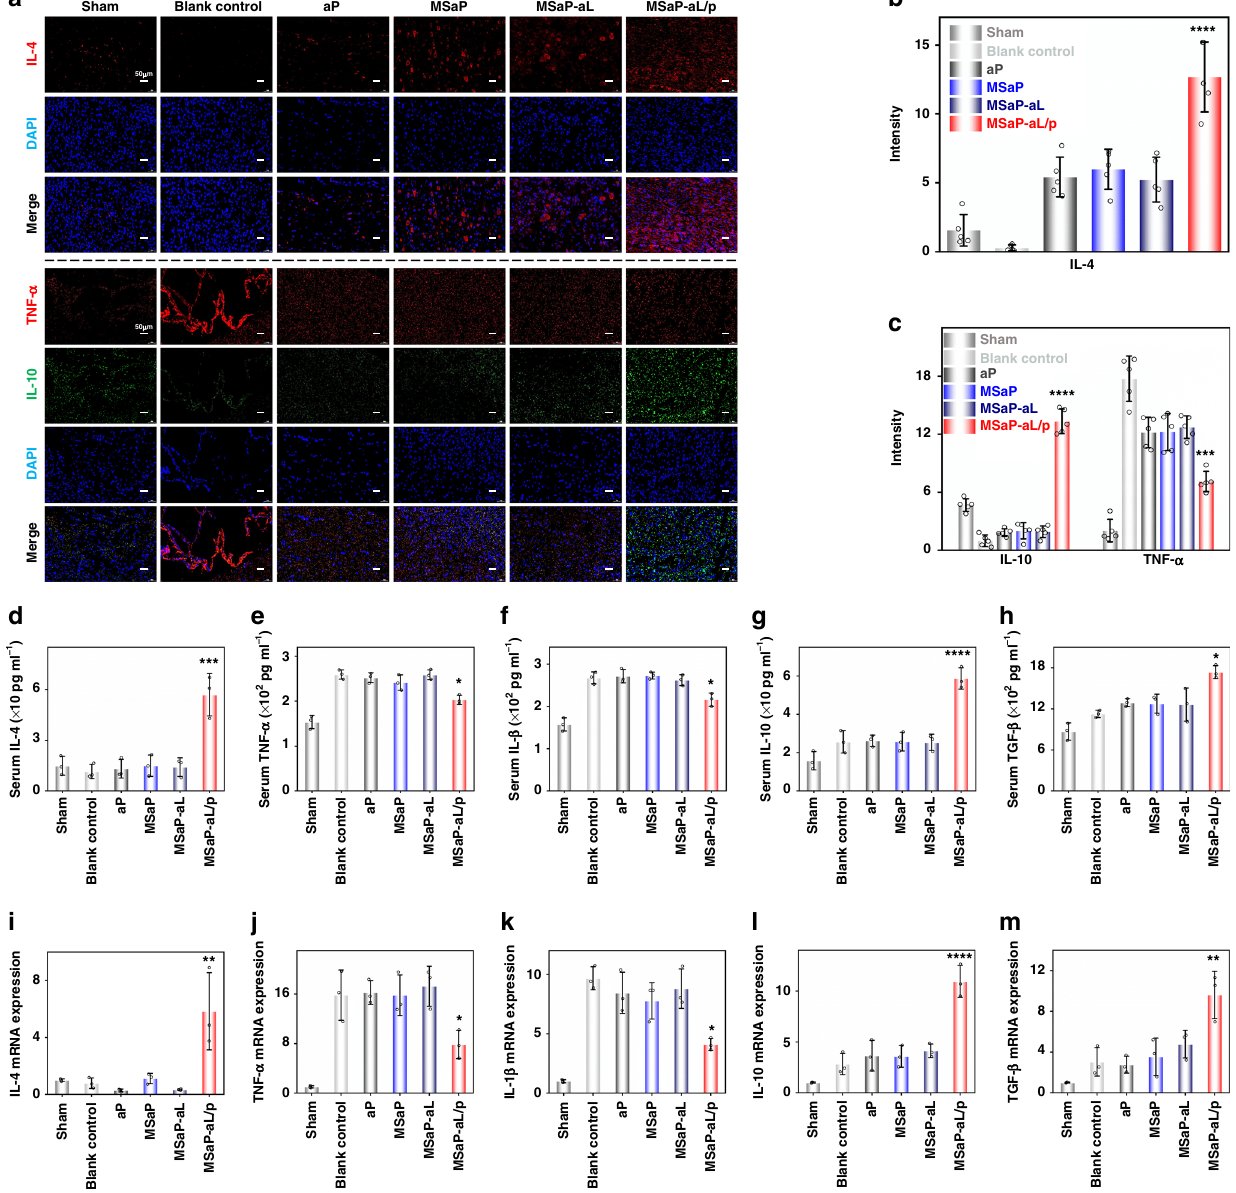
Fig. 10 Evaluation of immune regulation 7 days after operation. a IL-4 immuno fl uorescence single labeling and TNF- α , IL-10 immuno fl uorescence double labeling (scale bars were 50 µ m, 4 independent experiments). Quantitatively analysis of b IL-4 immuno fl uorescence, c IL-10 and TNF- α immuno fl uorescence ( n = 5, all values were mean ± std. dev., *** p < 0.001, **** p < 0.0001 when comparing MSaP-aL/p and other groups via two-way analysis of variance (ANOVA) with Tukey ’ s post hoc test). Spinal cord specimens of IL-4 ( d ), TNF- α ( e ), IL-1 β ( f ), IL-10 ( g ), and TGF- β ( h ) gene expression levels were assessed by qRT-PCR. Serum levels of IL-4 ( i ), TNF- α ( j ), IL-1 β ( k ), IL-10 ( l ), and TGF- β ( m ) were assessed by ELISA ( n = 3, qRT-PCR and ELISA values were mean ± std. dev., * p < 0.05, ** p < 0.01, *** p < 0.001, **** p < 0.0001 when comparing MSaP-aL/p and other groups via one-way analysis of variance (ANOVA) with Tukey ’ s post hoc